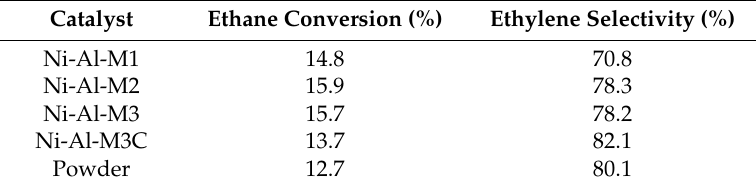
Table 4. Catalytic data at W/F = 0.48 g · s/cm 3 and 450 ◦ C (6% C 2 H 6 , 6% O 2 and He balance).